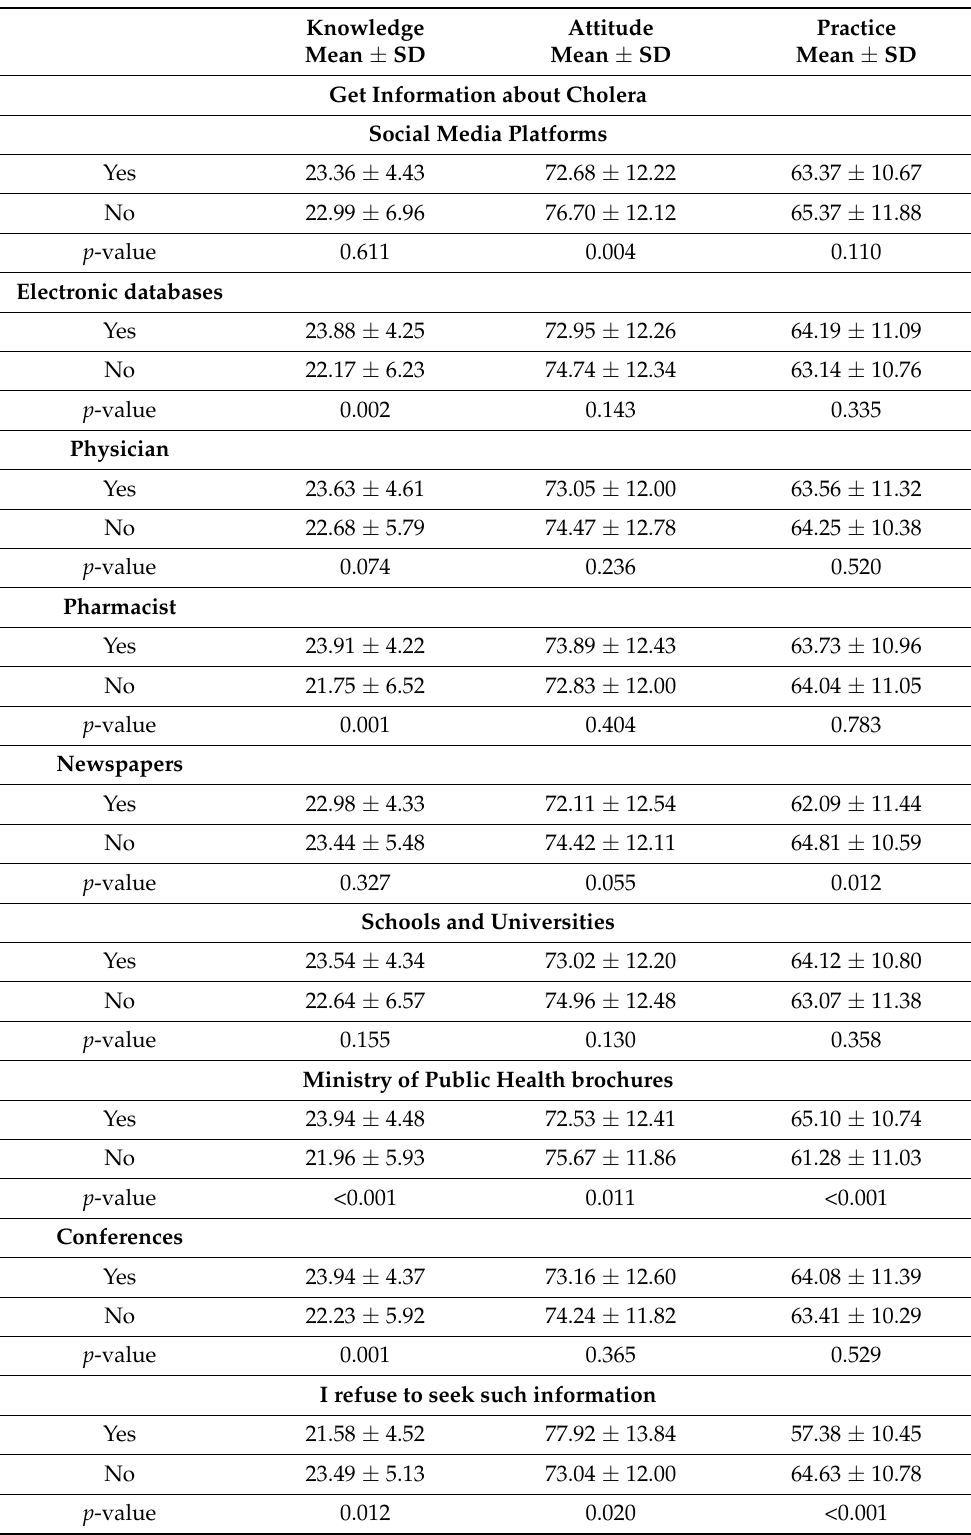
Table 6. Association between the source of information about cholera and the KAP